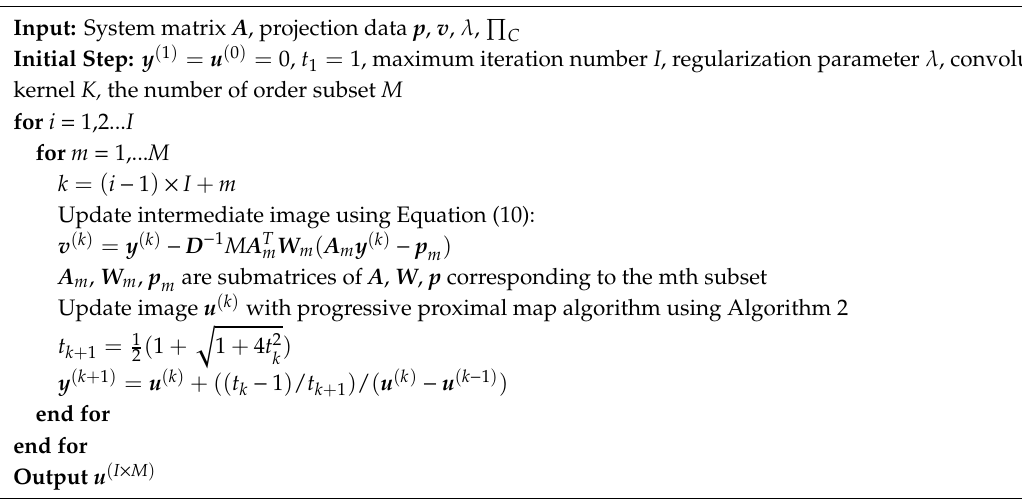
Algorithm 3 Workflow of the proposed accelerated